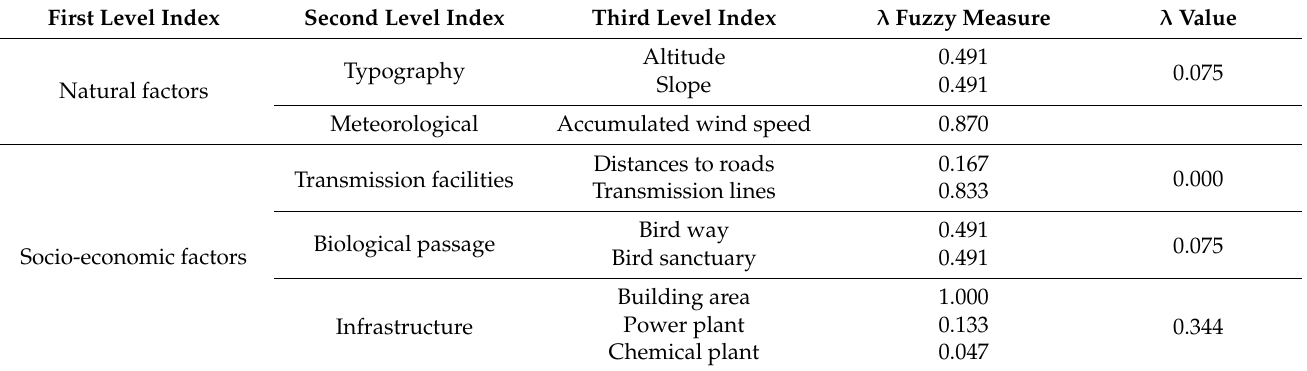
Table 3. The λ values and λ fuzzy measure of the third level